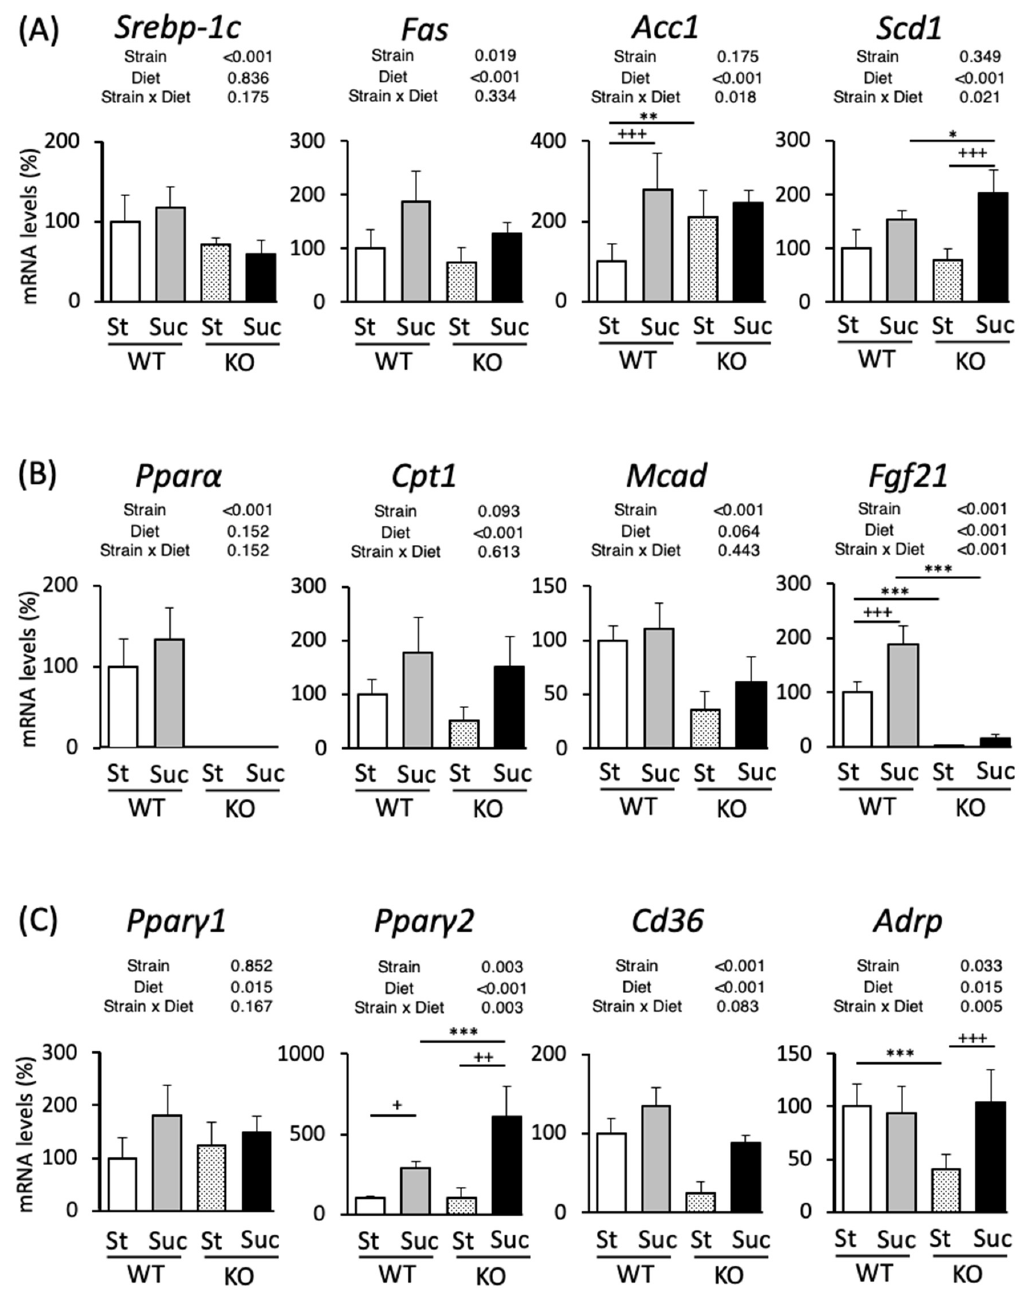
Figure 4. The hepatic gene expression in wild-type and PPAR α − / − female mice according to diet. The expression of genes related to fatty acid oxidation ( A ), fatty acid synthesis ( B ), and TG synthesis ( C ). The percentage of mRNA levels relative to St-fed WT mice are indicated. The inserted tables show the two-way ANOVA p values. * p < 0.05, ** p < 0.01, *** p < 0.001 between mice fed the same